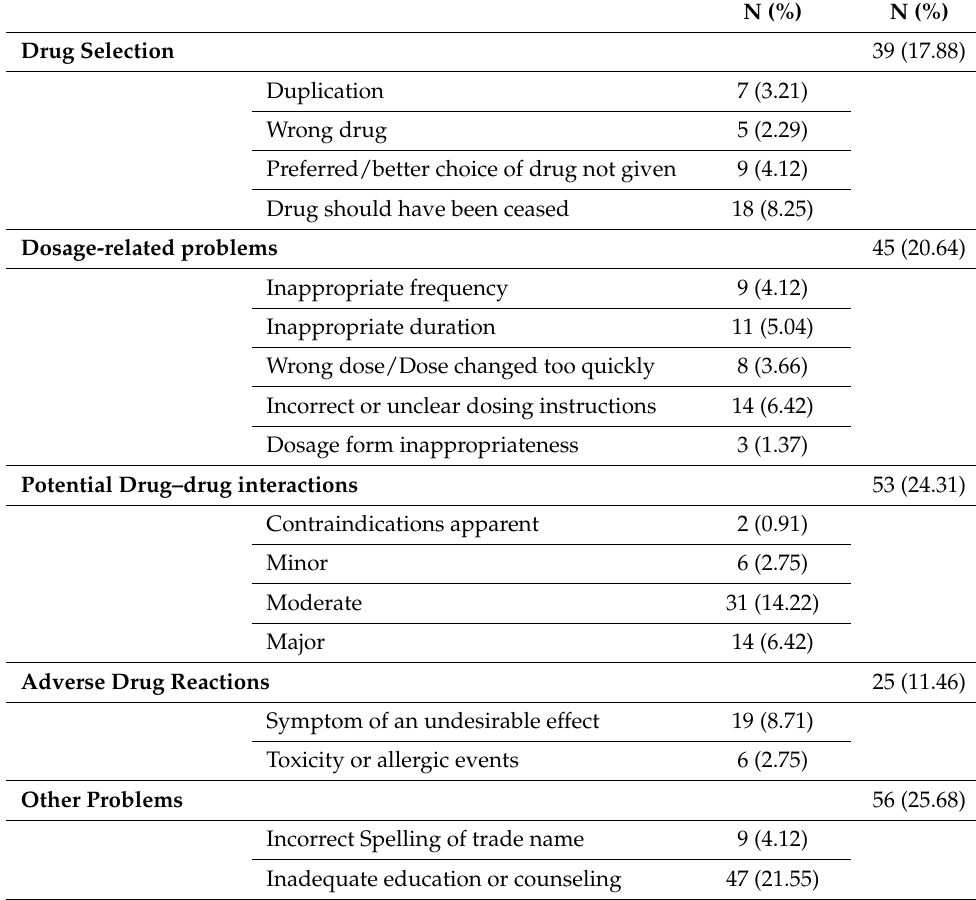
Table 4. Percentage wise distribution of drug-related problems (DRPs) in the treatment regimen prescribed to suicidal psychotic patients.